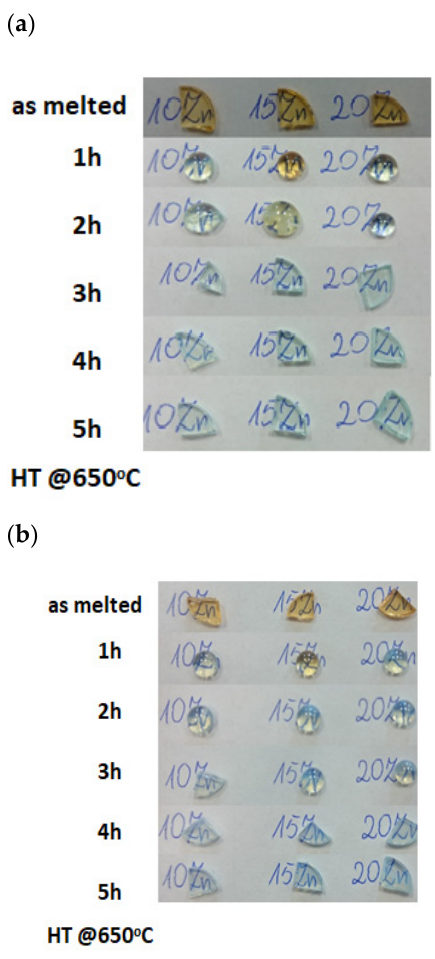
Figure 1. Image of the GGK with 10, 15, 20 ZnO glass and glass-ceramics (HT@650 °C for 1–5 h) ( a ) doped with 0.1 NiO, ( b ) co-doped with 0.1 NiO/0.1 Er 2 O 3 . FTIR spectra were recorded with a Bruker Company Vertex 70v spectrometer (Rhein- stetten, Germany). The MIR spectra were normalized to the highest peak. FTIR spectra have been decomposed using Fityk software (0.9.8 software, open-source (GPL2+)) based on the analysis of second derivatives with different degrees of smoothing. The coefficient of determination was 0.99. The standard deviation of the position of each of the component bands was ± 4 cm − 1 .